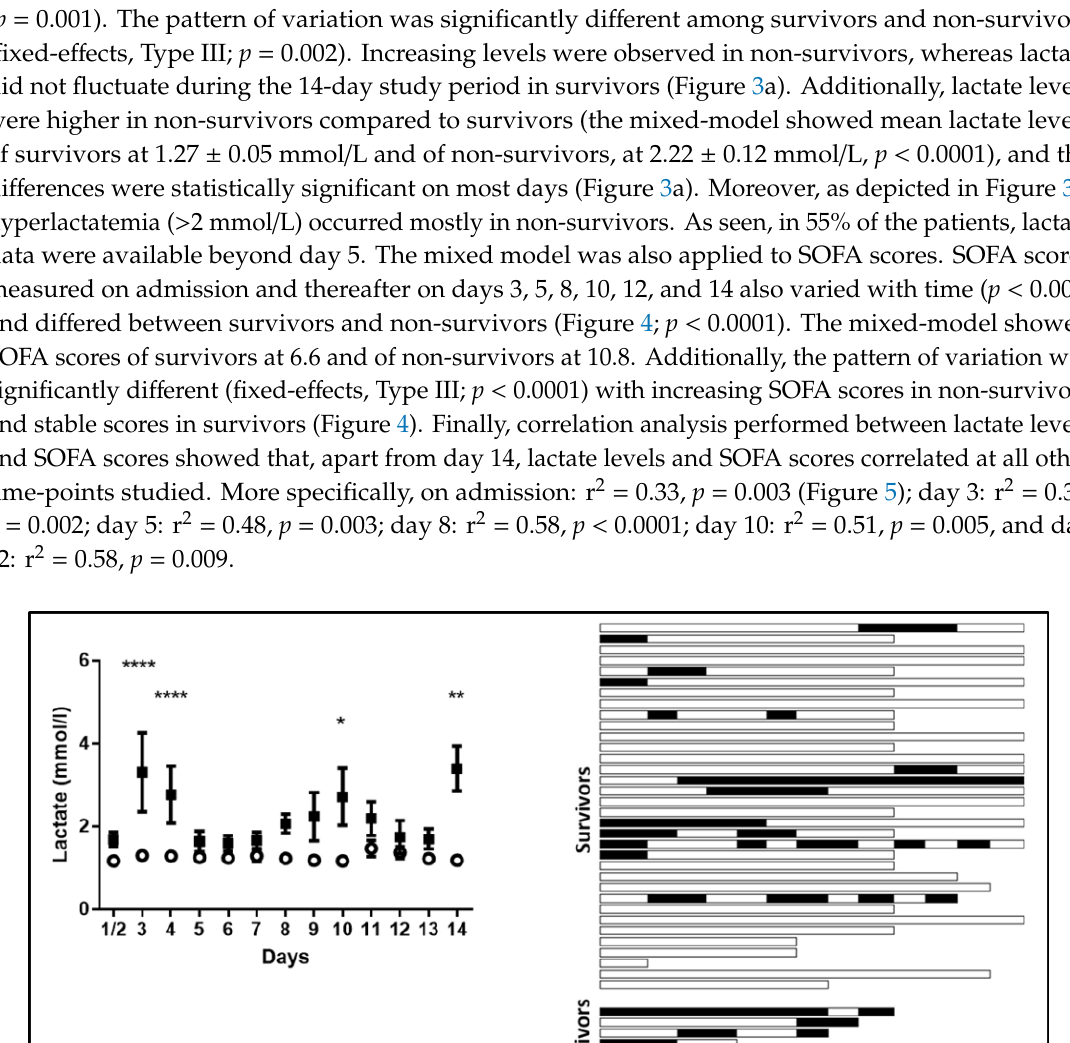
Figure 4. SOFA scores in survivors and non-survivors. SOFA scores and 28-day ICU mortality. Analysis was performed using mixed model fixed effect analysis for SOFA scores measured on admission, and days 3, 5, 8, 10, 12, and 14, using 28-day ICU mortality as the grouping factor. Open circle, survivors; closed square, non-survivors. * p < 0.05, **** p < 0.0001.